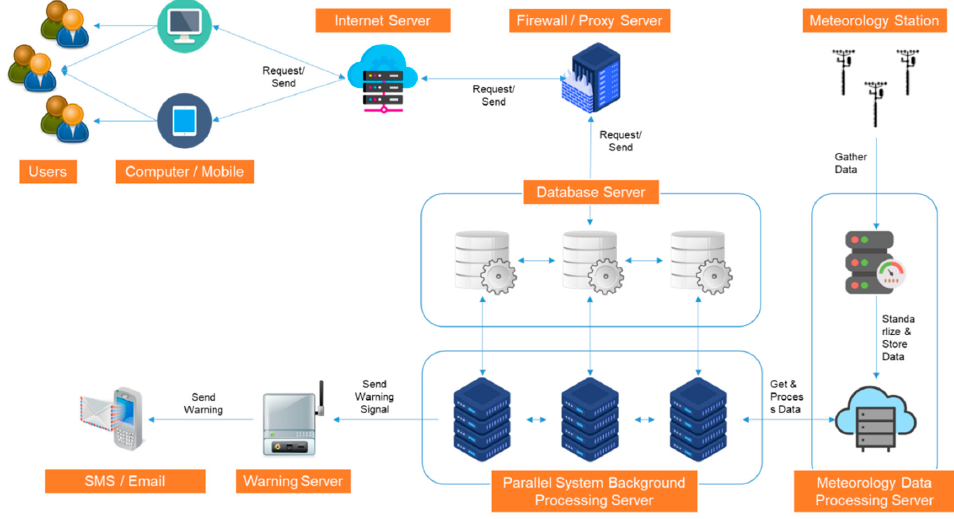
Figure 10. Model of the forest fire early warning system.